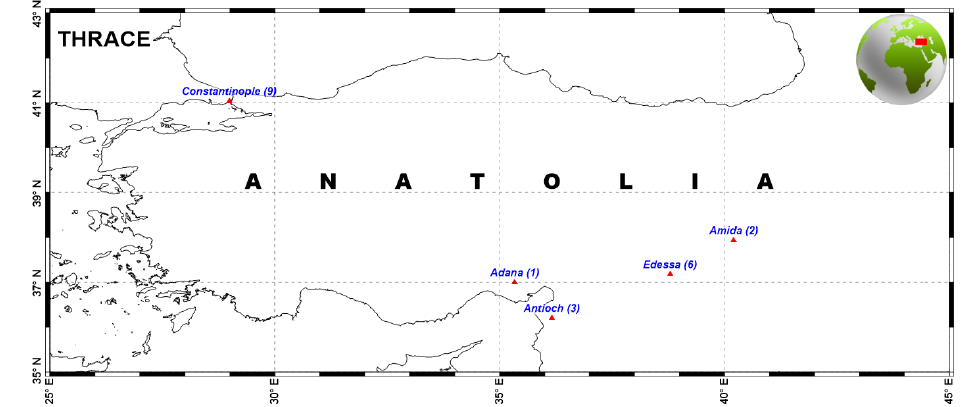
Figure 1. The location map of the historical aurora records during the Medieval period in Constantinople and Anatolia.